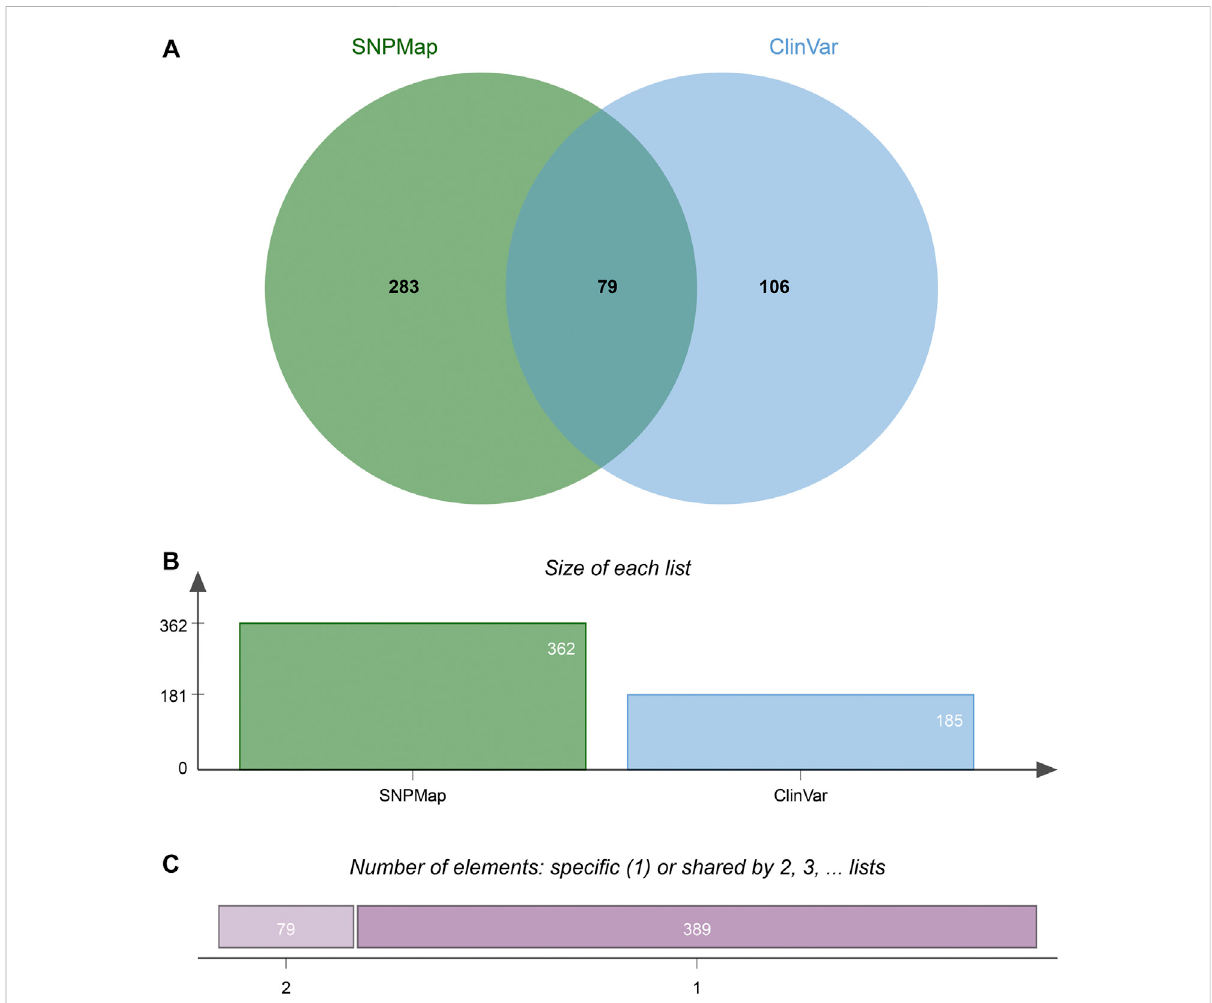
FIGURE 4 Thedifferenceofkeywords between SNPMapandClinVar of100randomselected SNPs. (A) Numbers ofkeywordsmentionedonlyinSNPMap, only in ClinVar, or in both. (B) Numbers of keywords mentioned in SNPMap, ClinVar. (C) Numbers of keywords mentioned in only one, or both platforms. The Venn diagram is generated with jvenn (Bardou et al., 2014).